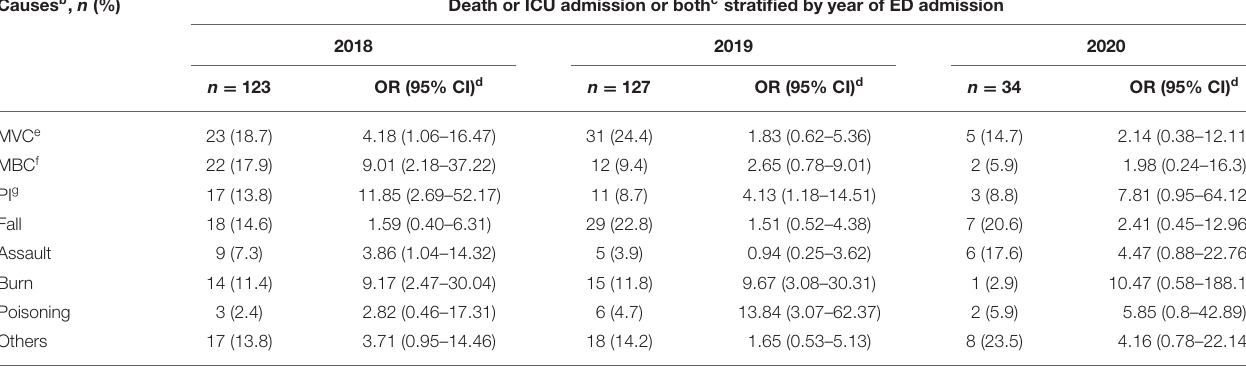
TABLE 4 | Causes (significant predictors) of death or ICU admission or both a . Causes b , n